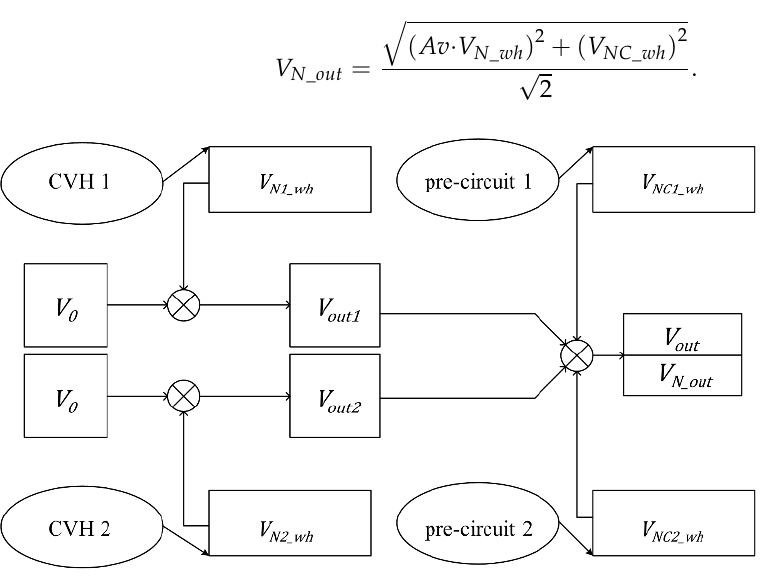
Figure 7. Signal transmission process of two CVHs.